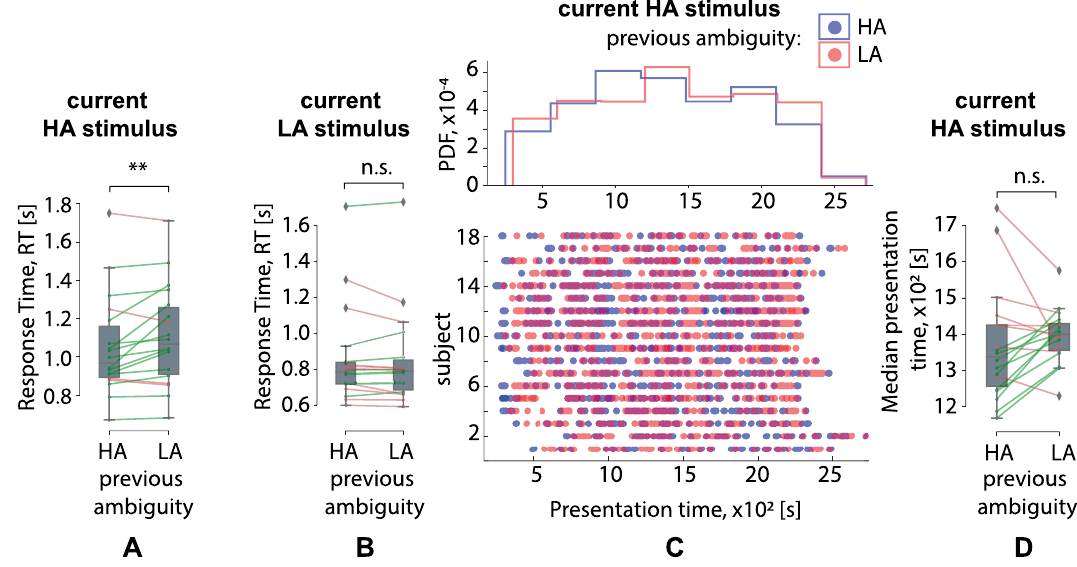
Figure 3. Effect of the previous stimulus ambiguity on the RT to the current stimulus. Box-plot illustrates the median RT in the group of subjects to ( A ) the HA stimuli, p < .017 ∗ and ( B ) LA stimuli, p = .727 ( B ) depending on the ambiguity of the previous stimulus. Dot-plot and histograms ( C ) show PT distributions for the HA stimuli following the HA and LA stimulus. Box-plot (D) reflects the median PT of the HA stimuli following the HA and LA stimuli in the group of subjects, p = .355 .